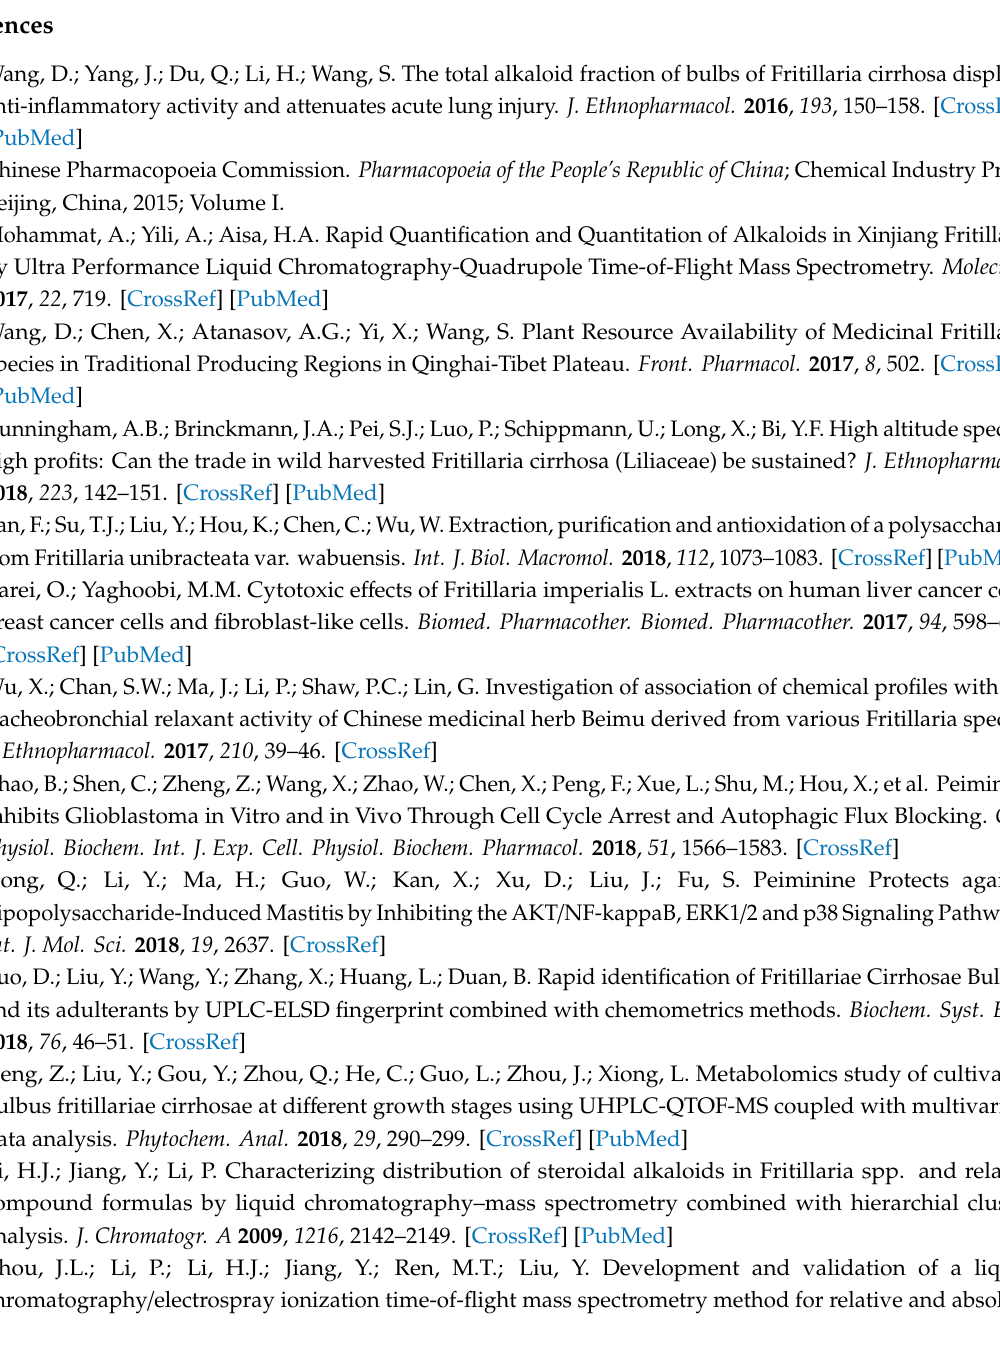
species, Figure S1: F. cirrhosa , Figure S2: Fritillaria delavayi, Figure S3: F. unibracteata , Figure S4: F. przewalskii , Figure S5: F. Taipaiensis , Figure S6: F. ussuriensis , Figure S7: F. walujewii , Figure S8: F. pallidiflora , Figure S9: F. thunbergii , Figure S10: F. hupehensis . Table S1: Detailed information about the materials used and sequences obtained in the study, Table S2: Sequences submitted in